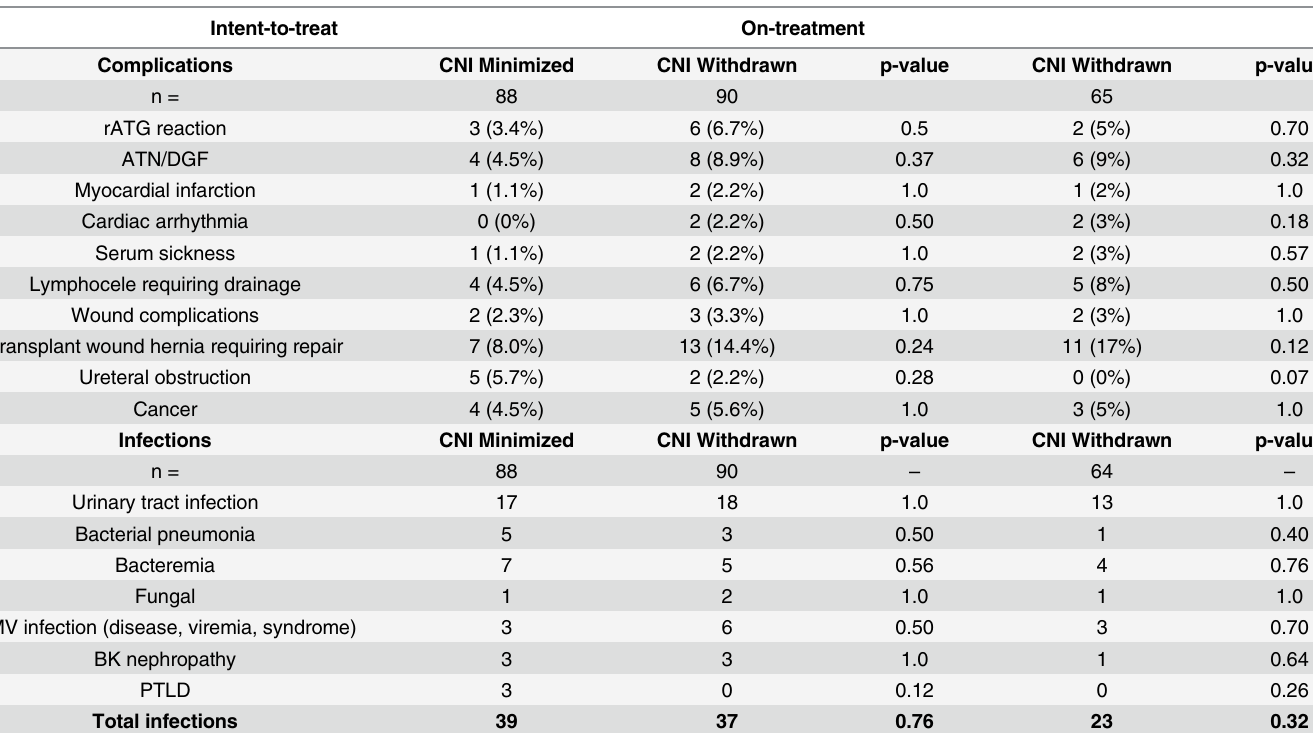
Table 5. Complications and